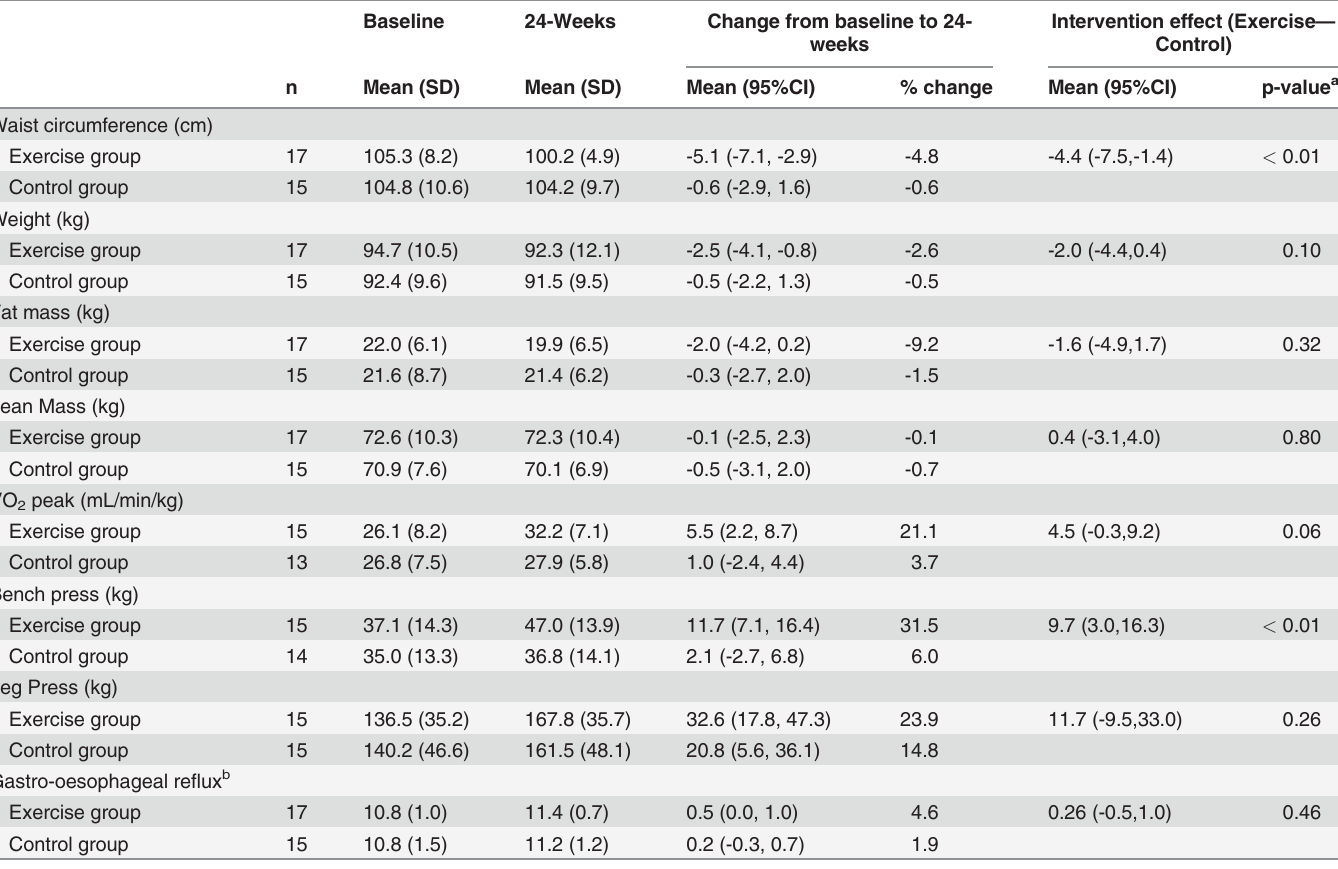
Table 3. Body composition, fi tness, strength and gastro-oesophageal re fl ux outcomes at baseline and week-24 comparing participants in the exercise group and control